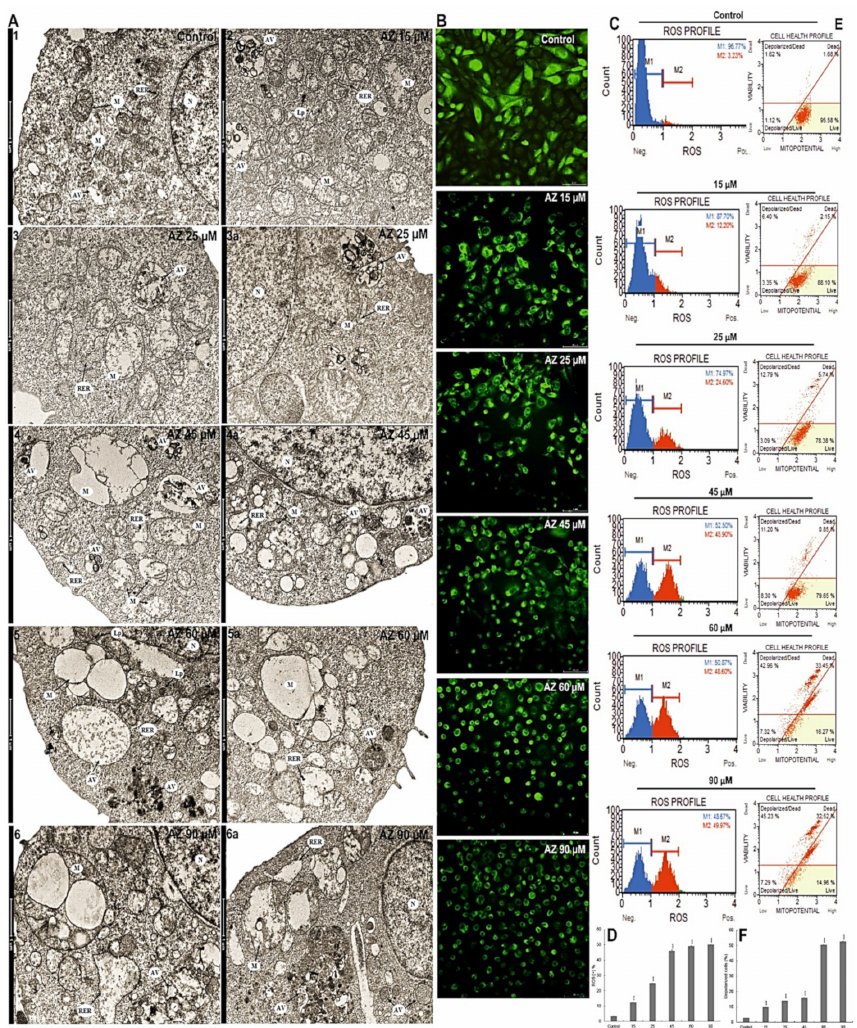
Figure 2. Changes in mitochondria, induction of oxidative stress, and endoplasmic reticulum stress in HeLa cells caused by the action of azelastine hydrochloride. Control cells ( A1 ). Azelastine concentration-dependent ultrastructural changes indicative of apoptosis ( A2 – 6a ); brightening of the matrix and irregular arrangement of cristae in the mitochondria of cells subjected to the 15 µ M concentration ( 2 ); at 25 µ M, visible enlarged mitochondria with reduction of mitochondrial cristae remaining in close proximity to the dilated channels of the rough endoplasmic reticulum ( 3 , 3a ); at a concentration of 45 µ M, mitochondria with enhanced damage characteristics are present, i.e., strongly enlarged with disruption of the mitochondrial membrane ( 4 ) and damaged mitochondrial cristae ( 4a ) and altered rough endoplasmic reticulum in the form of dilated channels ( 4 , 4a ); at concentrations of 60 µ M ( 5 , 5a ) and 90 µ M ( 6 , 6a ), visible mitochondria with severe disorganization of the structure indicating damage, and rough endoplasmic reticulum located in their vicinity with strongly enlarged and swollen cisterns. Explanation of abbreviations: N—nucleus, M—mitochondria, AG—Golgi apparatus, RER—rough endoplasmic reticulum, AV—autophagic vacuoles, Lp—primary lysosomes, Ls—secondary lysosomes. Images were taken at 11,500 × magnification. ( B ) Gradual and azelastine concentration-dependent loss of green fluorescence derived from rhodamine 123-labeled mitochondria. ( C ) Generation of reactive oxygen species and ( D ) percentage of ROS (+) cells as a result of azelastine. ( E ) Changes of mitochondrial membrane potential ( ∆ ψ m) and the percentage of cells with mitochondrial membrane depolarization ( F ) at different azelastine concentrations. Each sample was analyzed in triplicate. The differences were statistically confirmed at: *** p <